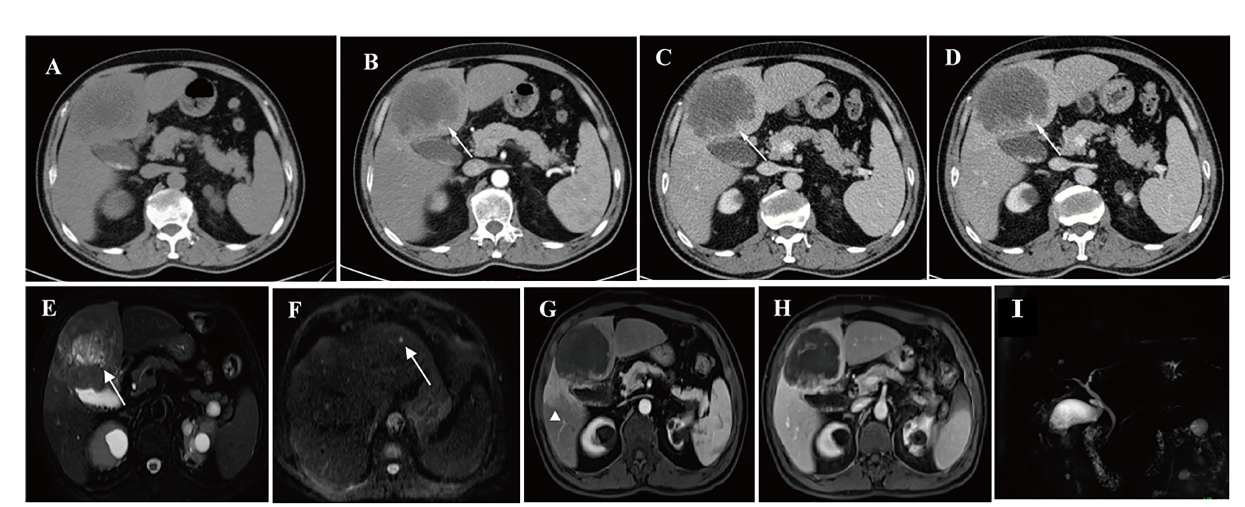
FIGURE 3 | CECT and mpMRI of a representative patient: this 62-year-old man was initially assessed as having a single nodule of intrahepatic cholangiocarcinoma by CECT, while an additional probable nodule was found by MR images with DWI. Pathological examination con fi rmed that the additional nodule was also ICC, the patients fi nally received extended liver resection to remove the primary and the secondary tumor module. (A – D) indicate a nodule showing typical features of ICC (rimenhancement in the arterial phase and no washout in the portal venous phase and delayed phase) in dynamic CT images (arrow): (A) pre-contrast phase; (B) arterial phase; (C) portal phase; and (D) delayed phase. (E – I) show dynamic MRI images with DWI and MRCP: (E) shows the same ICC nodule that was detected with DWI (arrow); (F) shows a probable ICC nodule that were found by DWI (arrow); (G) shows peritumor parenchymal arterial phase alteration (arrowhead) and no washout in portal venous phase (H) ; and no biliary dilation displays in (I)